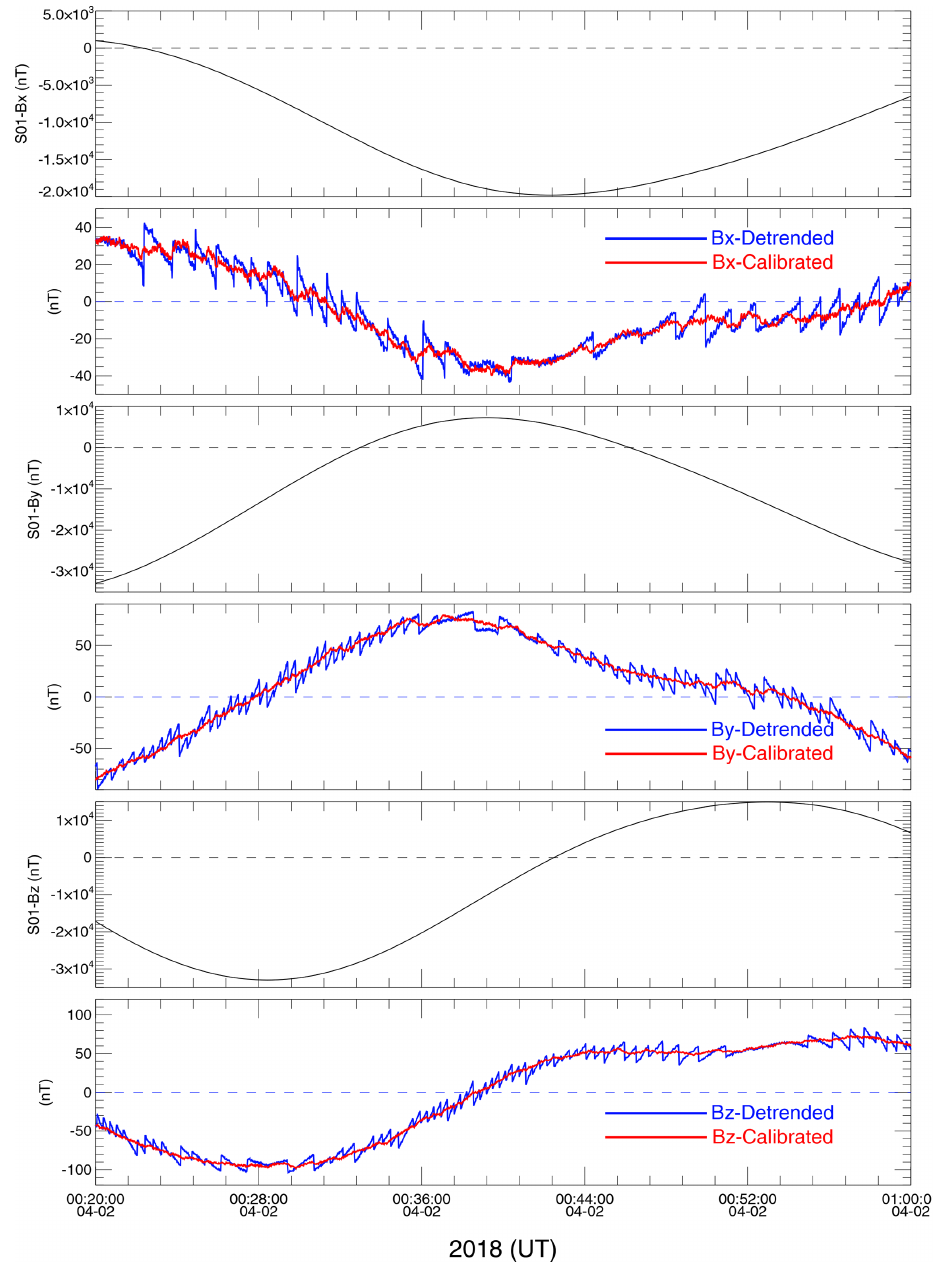
Figure 11. The overview of the LOPS-1 data before (blue) and after dynamic interference correction (red).